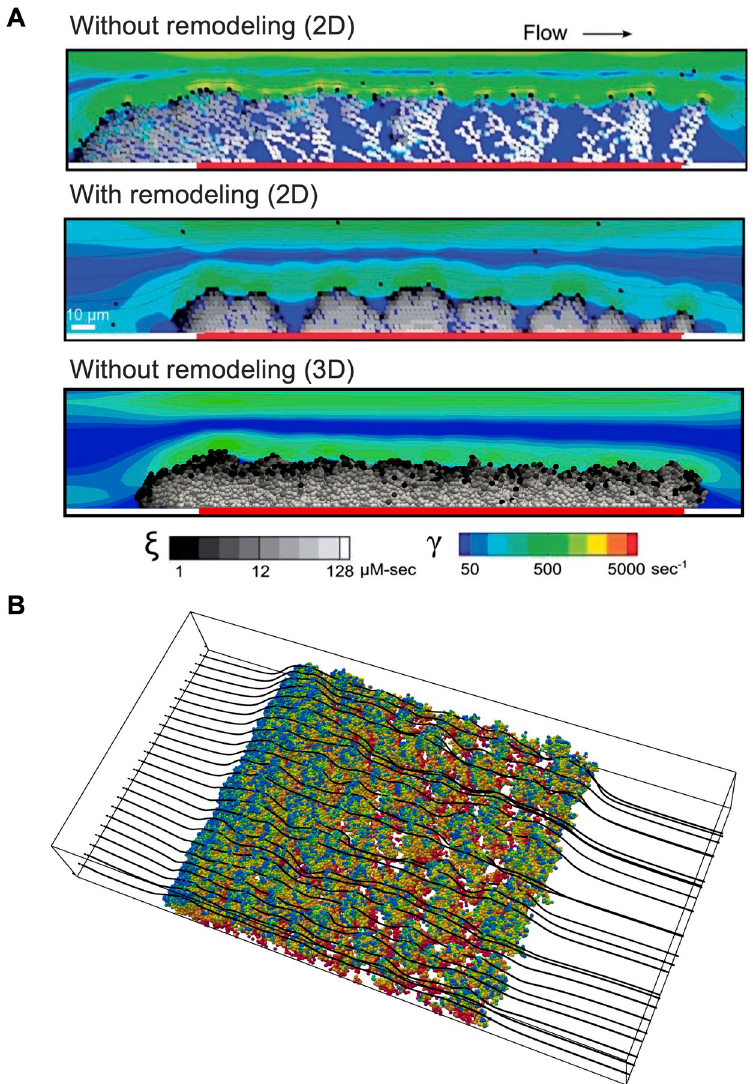
Fig 3. Comparison between prior 2D simulations and present 3D simulations. (A) Thrombus morphology observed in 2D simulations (top) showing highly dendritic aggregate growth. A clot remodeling scheme was required in 2D to obtain a realistic morphology (middle). Thrombus morphology observed in 3D without employing a remodeling scheme (bottom). (B) Thrombus morphology observed in present work in 3D. Dendritic aggregate formation is drastically reduced due to realistic platelet trajectories in 3D, as evidenced by flow streamlines (black lines) that show flow around